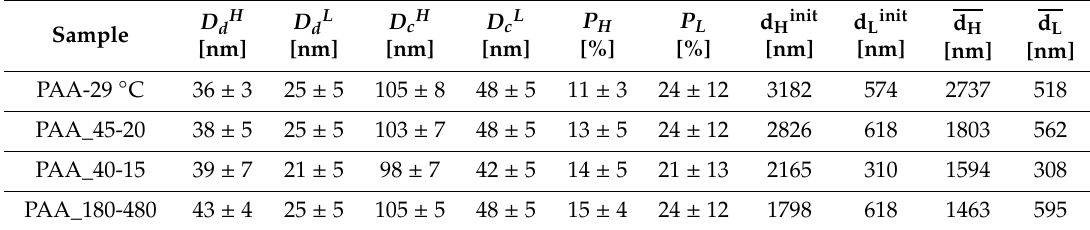
Figure 11. PAA growth rate ( k PAA ) as a function of applied voltage for T = 30 °C ( a ), SEM images of the d Linit and d Hinit layers (top views) formed under U L = 20 V ( b ), U H = 50 V ( c ), U L = 15 V ( d , e ), U H = 40 V ( f ) pulses at 30 °C. Table 2. Geometrical parameters of PAA layers: D dH and D dL —pore diameters, D cH and D cL —interpore distances, P H and P L —porosity of the d H and d L segments, respectively; d Hinit and d Linit are the initial segments formed under first U H and U L pulses, respectively; d H and d L are the mean values of both initial and final thicknesses of d H and d L layers, respectively.